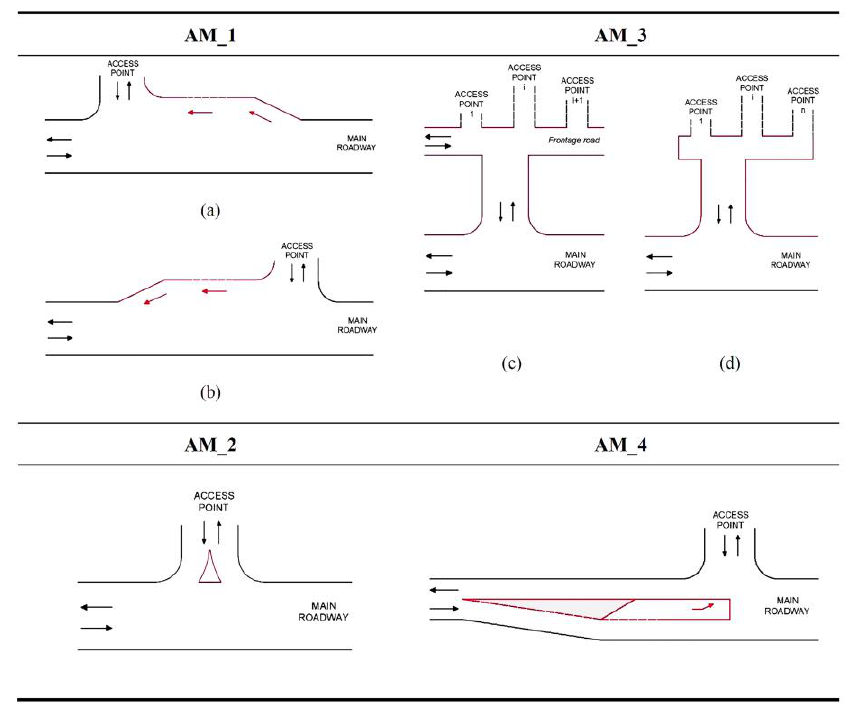
Figure 3. Access Management measures (top view); ( a ) right-turn deceleration lane, ( b ) right-turn acceleration lane, ( c ) frontage or service roads (a parallel road to the main roadway which is used to provide connection to lateral facilities and private developments), ( d ) shared access (the access is shared by more than two adjacent access points). The red line identifies the roadway modification linked to each specific access management measure.